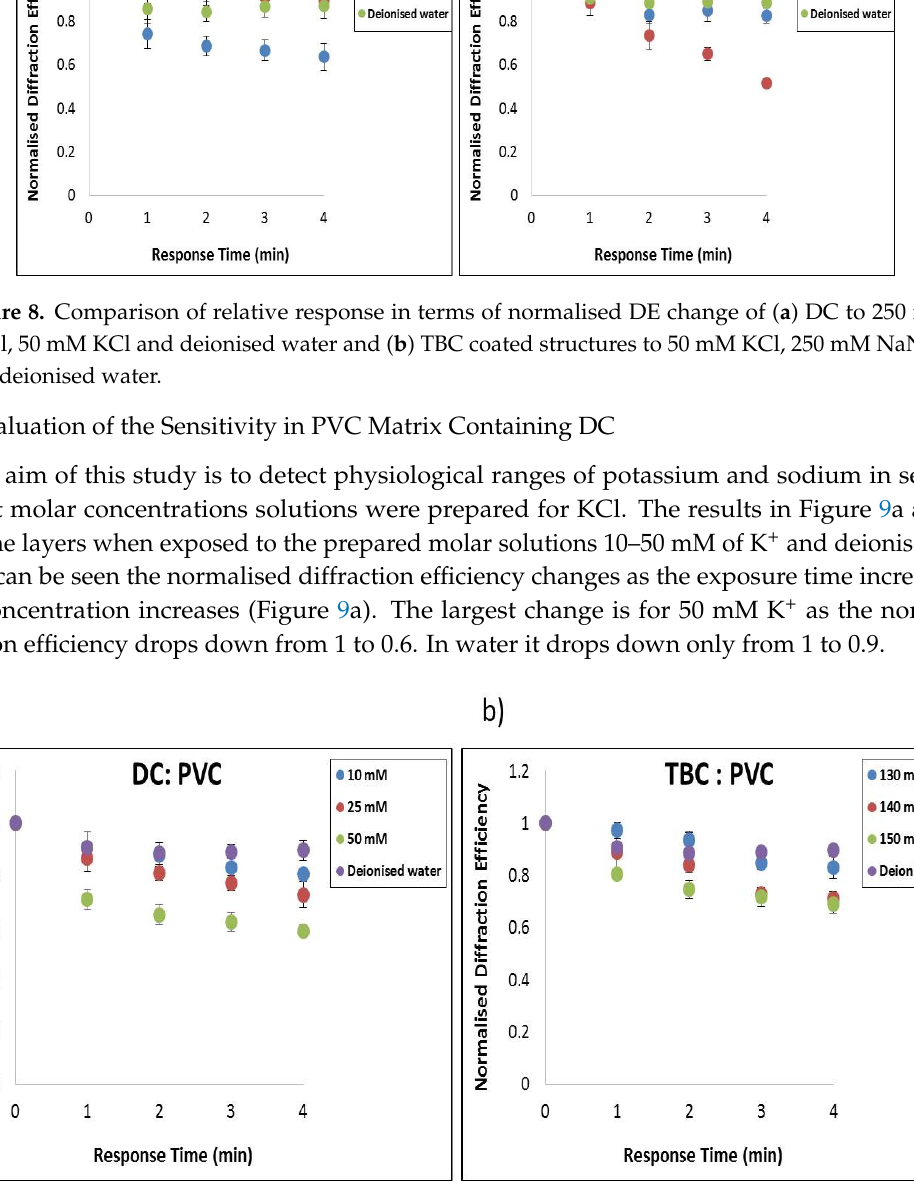
10 of 16 Figure 7. Bragg curves for SRG ( ), after spin coating with (DC) / PVC layer ( ) and after exposure to analyte K + (50 mM) ( , ). In order to evaluate the response of the structure to the analyte, measurements of the peak diffraction efficiency were taken at different times. 3.3. Evaluation of the Selectivity and Sensitivity Response of the Sensor Achieved by Coating with DC or